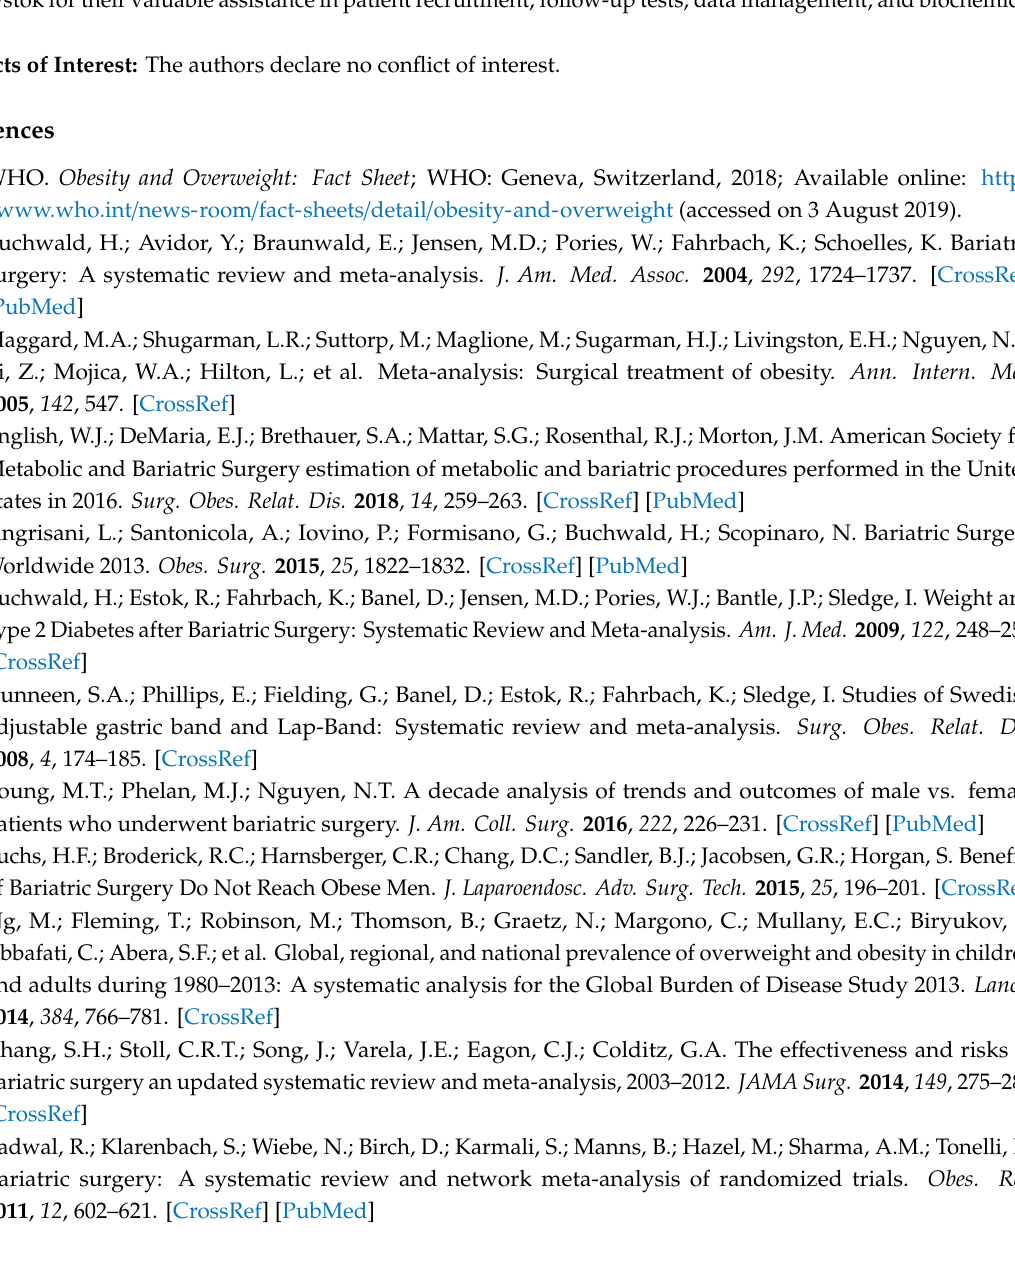
Table S1: quantile regression results; Appendix S1: anthropometric linear and quadratic GLMM results with all covariate combinations; Appendix S2: metabolic linear and quadratic GLMM results with all covariate